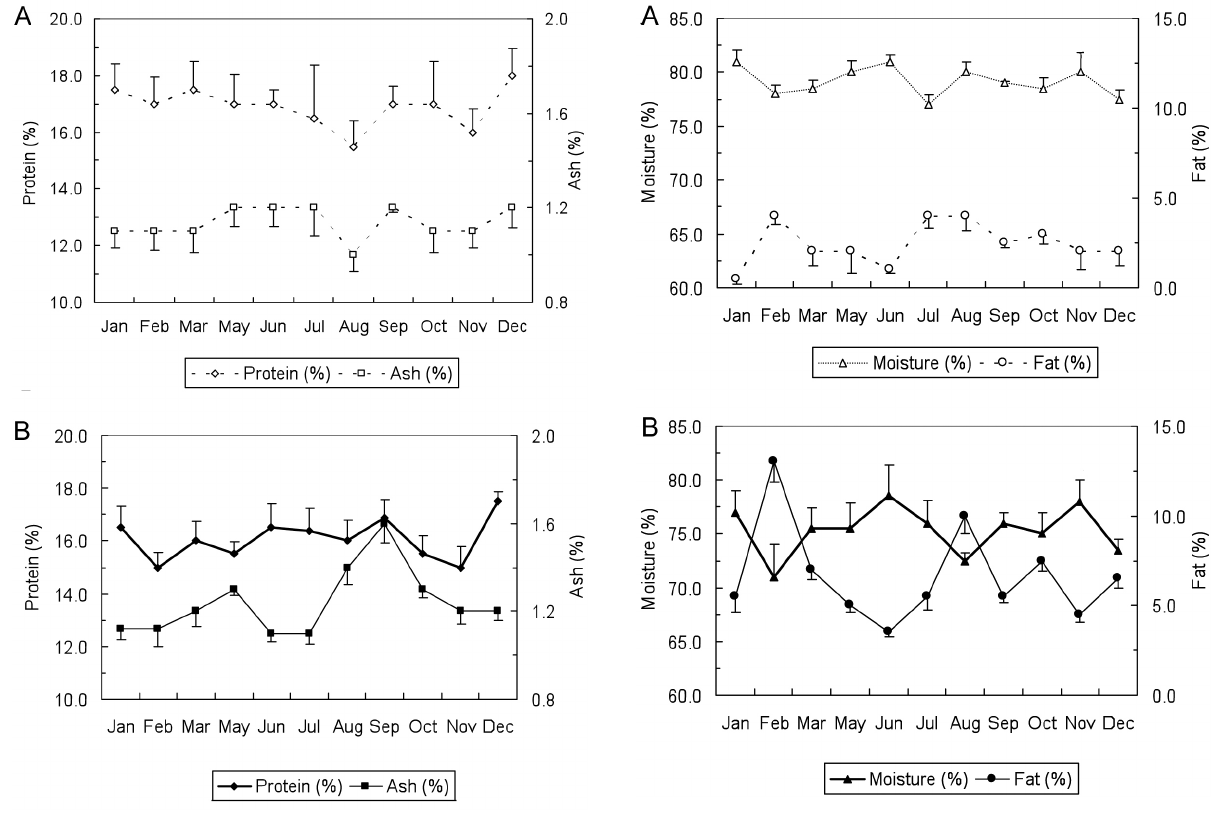
Fig . 3 – seasonal evolution of moisture and fat content in black scabbardfish fillets (a, skin-on; B, skinless).